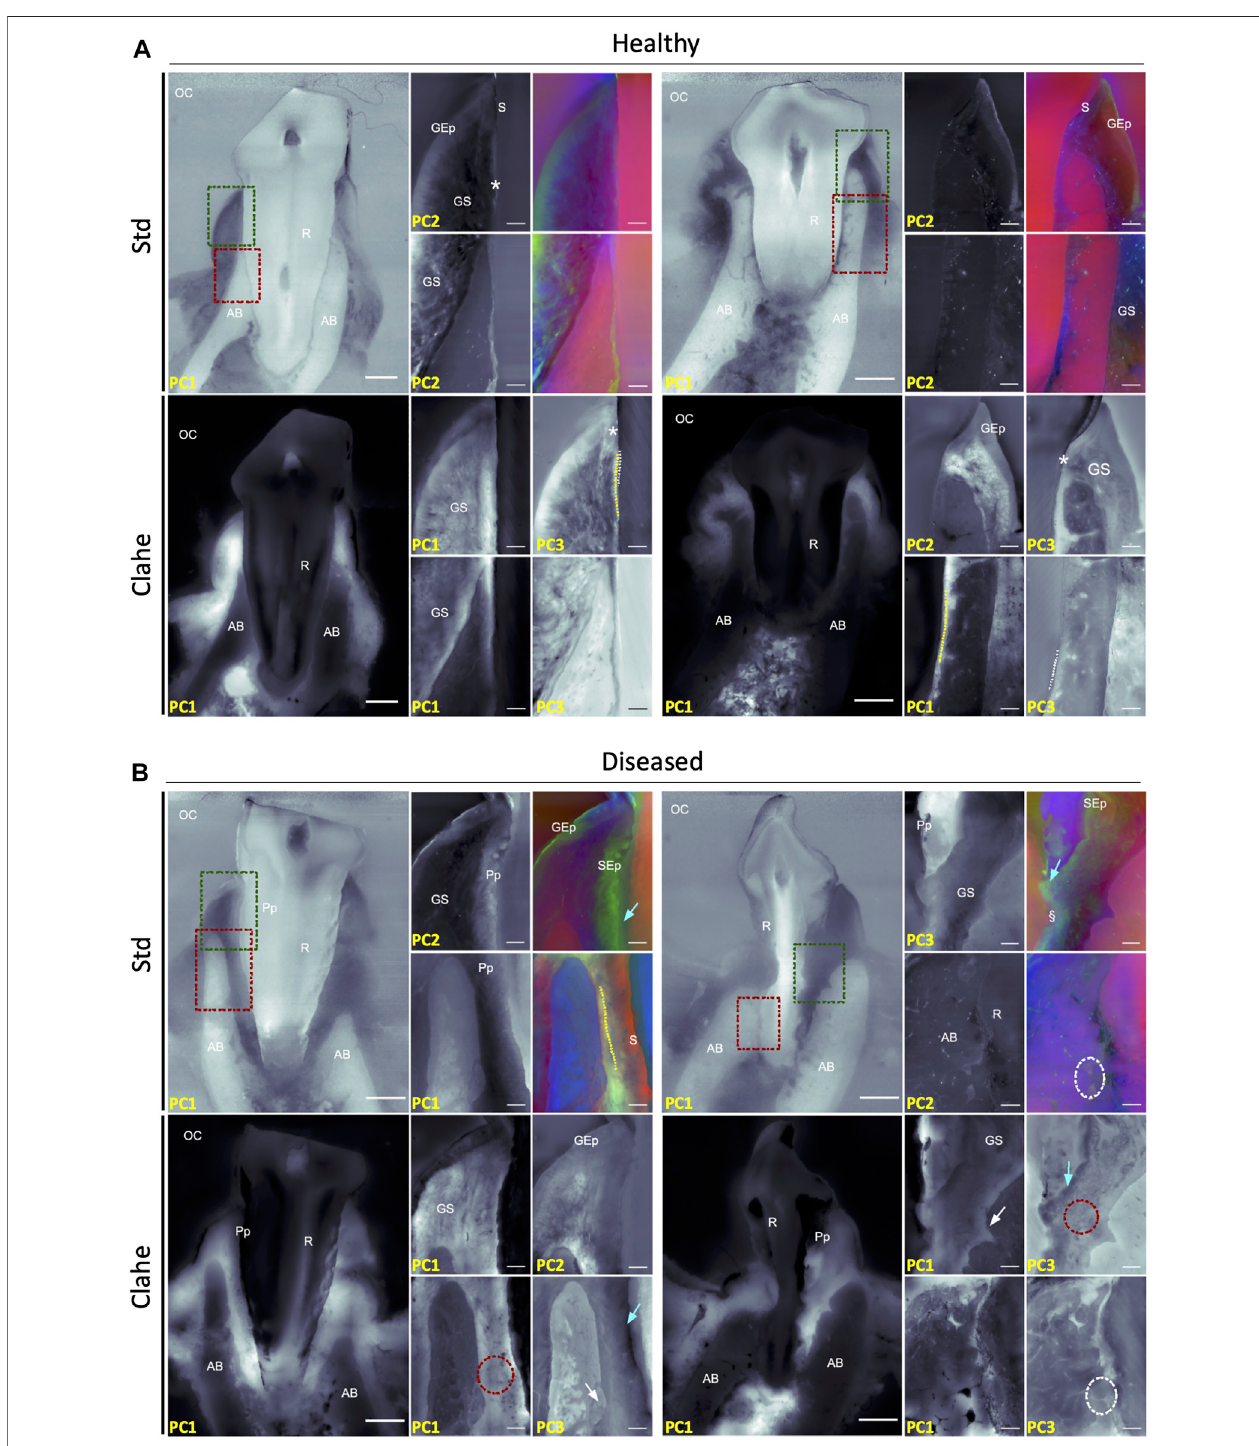
FIGURE4| Spectral analysisofthehealthyand diseasedcanineperiodontium.Foreach case,theeigen-image themostcontributive forhistopathologicalanalysis was presented. (A) — Short gingival sulcus (S), regular acanthosis in the marginal gingival epithelium (GEp), adherent junctional epithelium (*), homogenous gingival stroma (GS), regular-thickness cement (white dashed lines) and PDL (periodontal ligament, yellow dashed lines), and non-resorbed alveolar bone (AB) in canine healthy periodontium. (B) — Periodontal pocket (Pp) with deep gingival sulcus exhibiting non-regular acanthosis involving sulcular epithelium (SEp), long junctional epithelium(bluearrows),heterogeneous fi berarrangementingingivalstroma,enlargedPDLthickness(reddashedcircles)withresorbed(whitearrows)and/orankylosed (white dashed circles) root and bone in diseased periodontium. Note the interface between the long junctional epithelium and the root at the bottom of the periodontal pocket (§). OC: oral cavity. R: tooth root. Scale bar: 2000 µm (low magni fi cation), 500 µm (high magni fi cation).